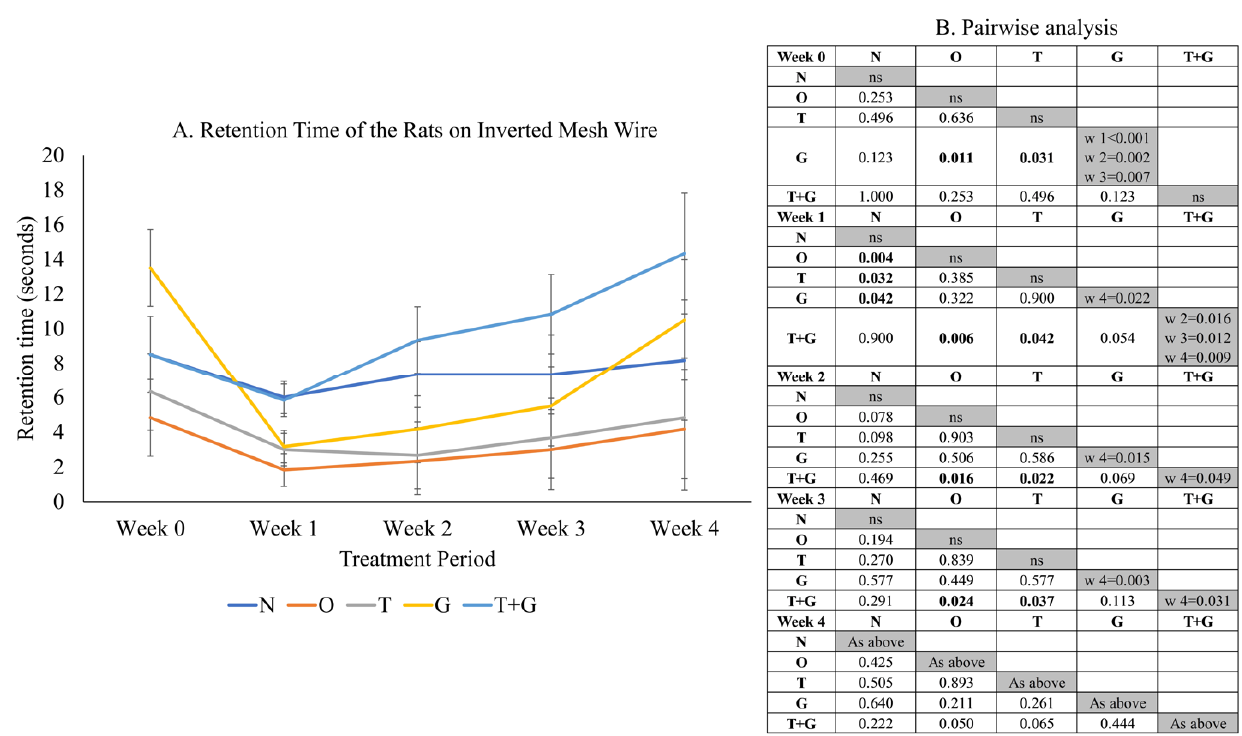
Figure 3. Grip strength (mean ± standard error) of the rats throughout the study ( A ). The results of inter ‐ ( p ‐ values) and intra ‐ group comparisons (weeks that show a significant difference) obtained from mixed ‐ design analysis of variance are depicted in ( B ). The values in the shaded area indicate a significant difference of the group at that week compared to other weeks (0–4). The significant difference is defined at p < 0.05. Abbreviation: ns: no significant difference; N: normal control;